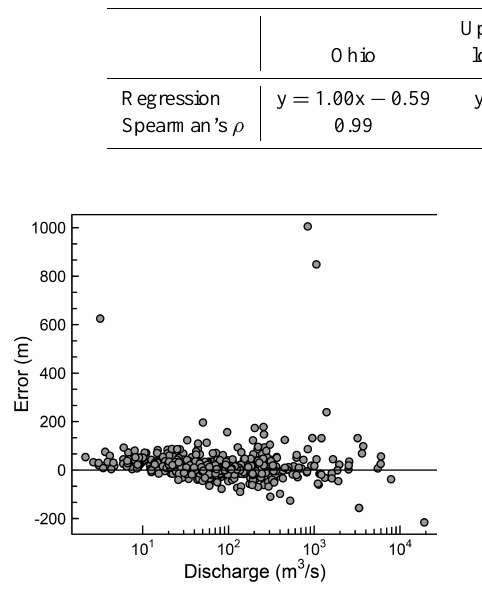
Figure 8. Width measurement error based on in situ channel mea- surements from 456 USGS streamflow gauging stations.